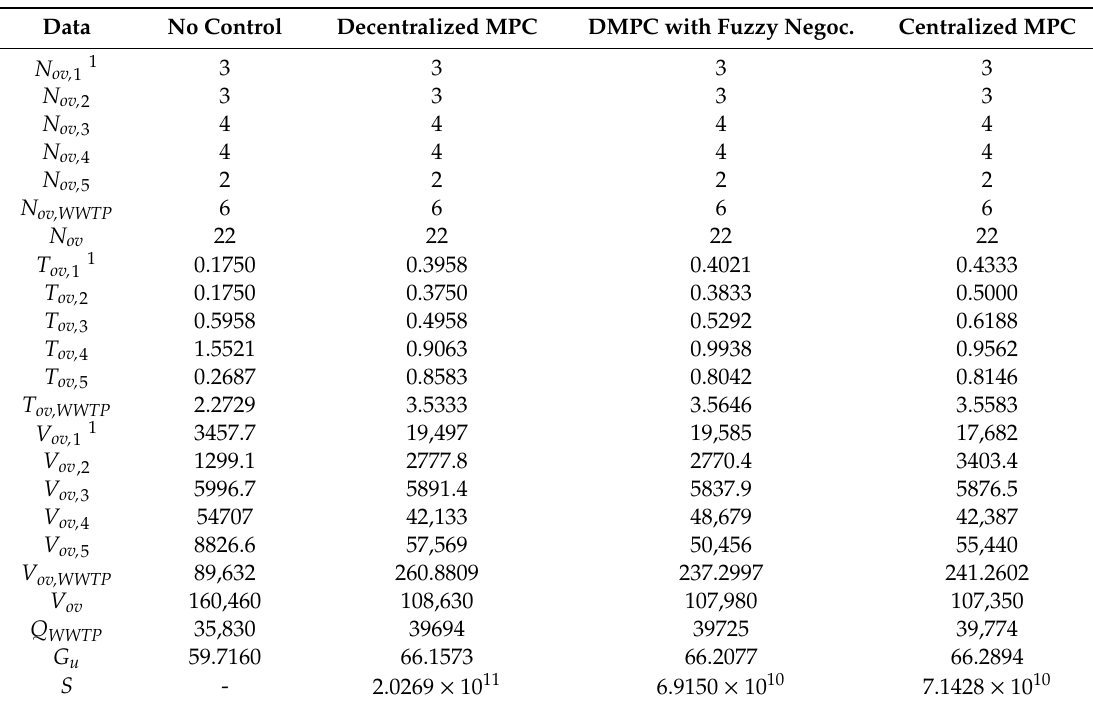
Figure 16. Tank 4 level ( a ) and output flow rate set point ( b ). Table 6. Numeric results for scenario